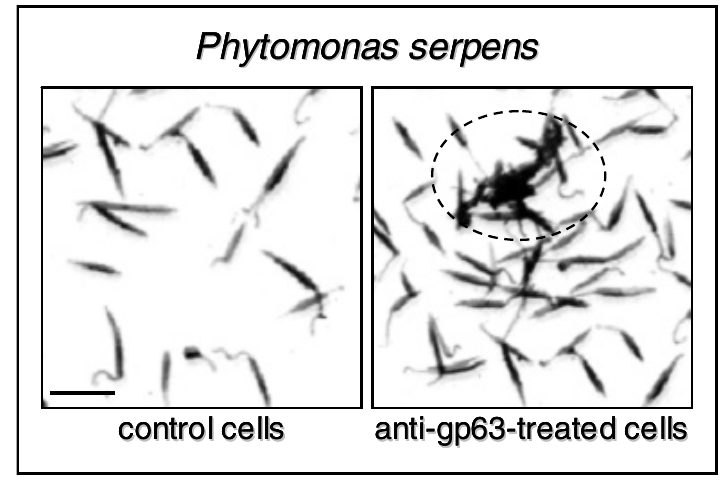
Fig. 7 – Binding of anti-gp63 antibodies (Ilg et al. 1993) to the cell surface of Phytomonas serpens promastigote cells. The living parasites were incubated in the presence of the rabbit pre-immune serum ( control cells ) or rabbit anti-gp63 serum ( anti-gp63-treated cells ) at 1:100 dilution for 1 h. Then, cells were fixed and experimental systems were analyzed under phase contrast images. The selected area indicates the agglutination of parasites by the anti-gp63 antibody. The bar represents 10 µ m. For experimental details see d’Avila-Levy et al.